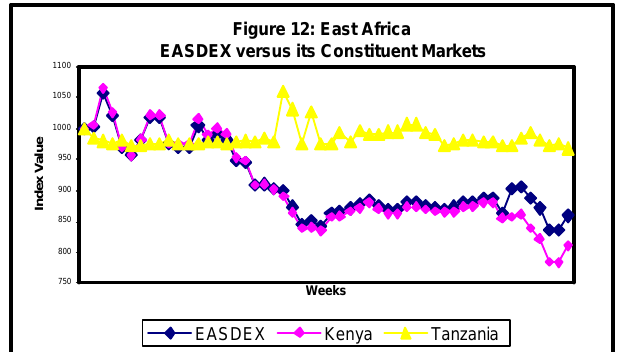
Figure 12: East Africa EASDEX versus its Constituent